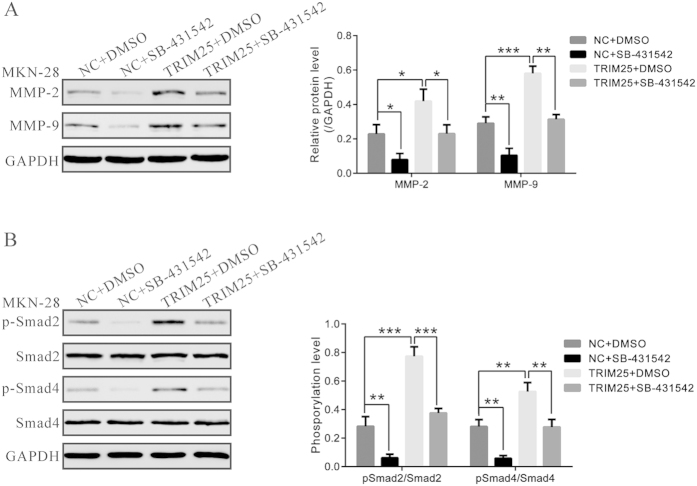
Ectopic expression of TRIM25 reversed the effects of TGF-β inhibitor on TGF-β signaling.(A) Expression of MMP-2 and MMP-9 was evaluated by immunoblotting. (B) Phosphorylation of Smad2 and Smad4 was determined by immunoblotting (*P < 0.05, **P < 0.01, ***P < 0.001).